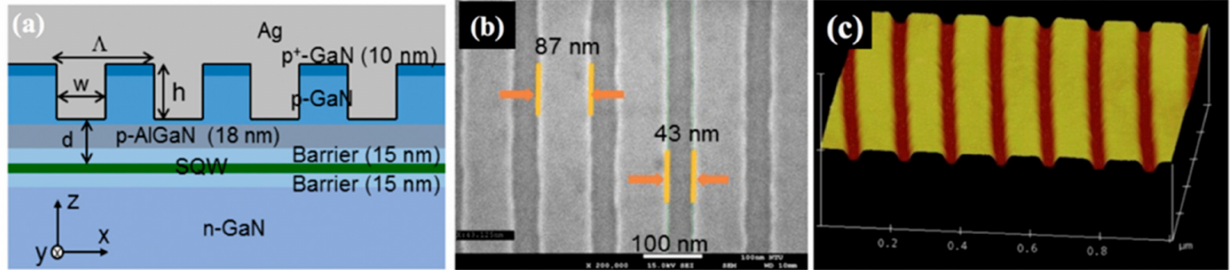
Figure 7. ( a ) Schematic demonstration of an LED structure with an Ag grating on the top. ( b ) Plan-view SEM and ( c ) tilted AFM images, respectively, of the grating structure before Ag deposition in one of the LEDs. Reprinted with permission from [48]. Copyright 2018 The Optical